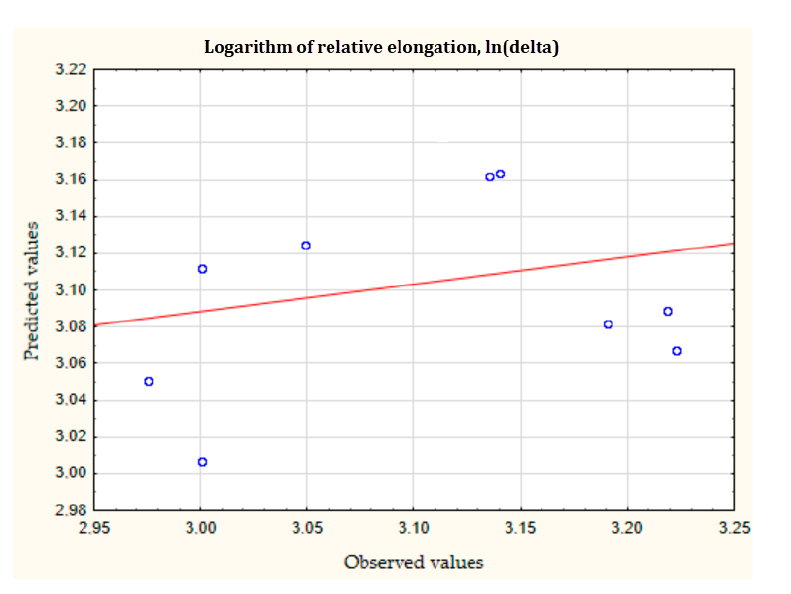
Figure 4. The observed and predicted yield strength values. To solve the optimization problem, it was necessary to consider the technological parameters and limitations that formed the range of acceptable values for the LPBF pro- cess with the HN58MBYu alloy. The initial data for the LP optimization process can be found in Table 6. The maximum and minimum parameter values in the table had to be grouped according to the previously defined recommended base values (lines 13–16, Table 6) and they had to not go beyond the range of the experimental data (Table 2). The lower and upper limits of deviations from the recommended values were also calculated from Equation (2) and are indicated in the matrix of constraints. Figure 5 shows the scheme for measuring the melting pool depth from microstructure data. To do this, a single track (or layer) was welded onto the substrate and the value of depth c was measured from microstructure data. To reveal the microstructure of the transverse sec- tions of the specimens, they were etched in a reagent (35 mL HCl, 24 mL HNO 3 , 6 mL HF, 35 mL H 2 O).